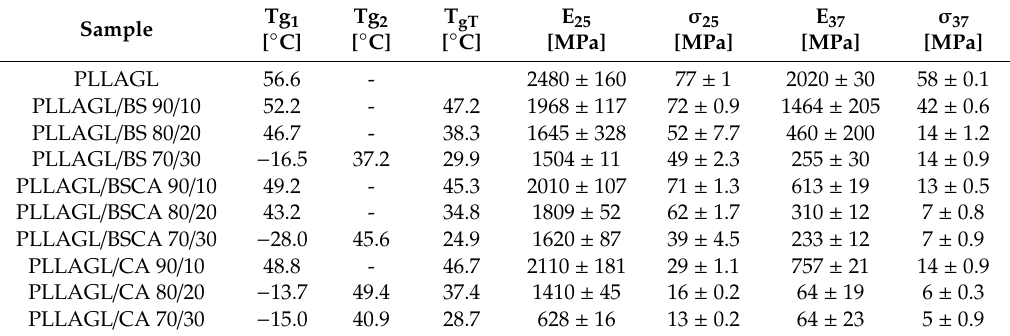
Table 2. Thermomechanical characteristics of obtained blends.